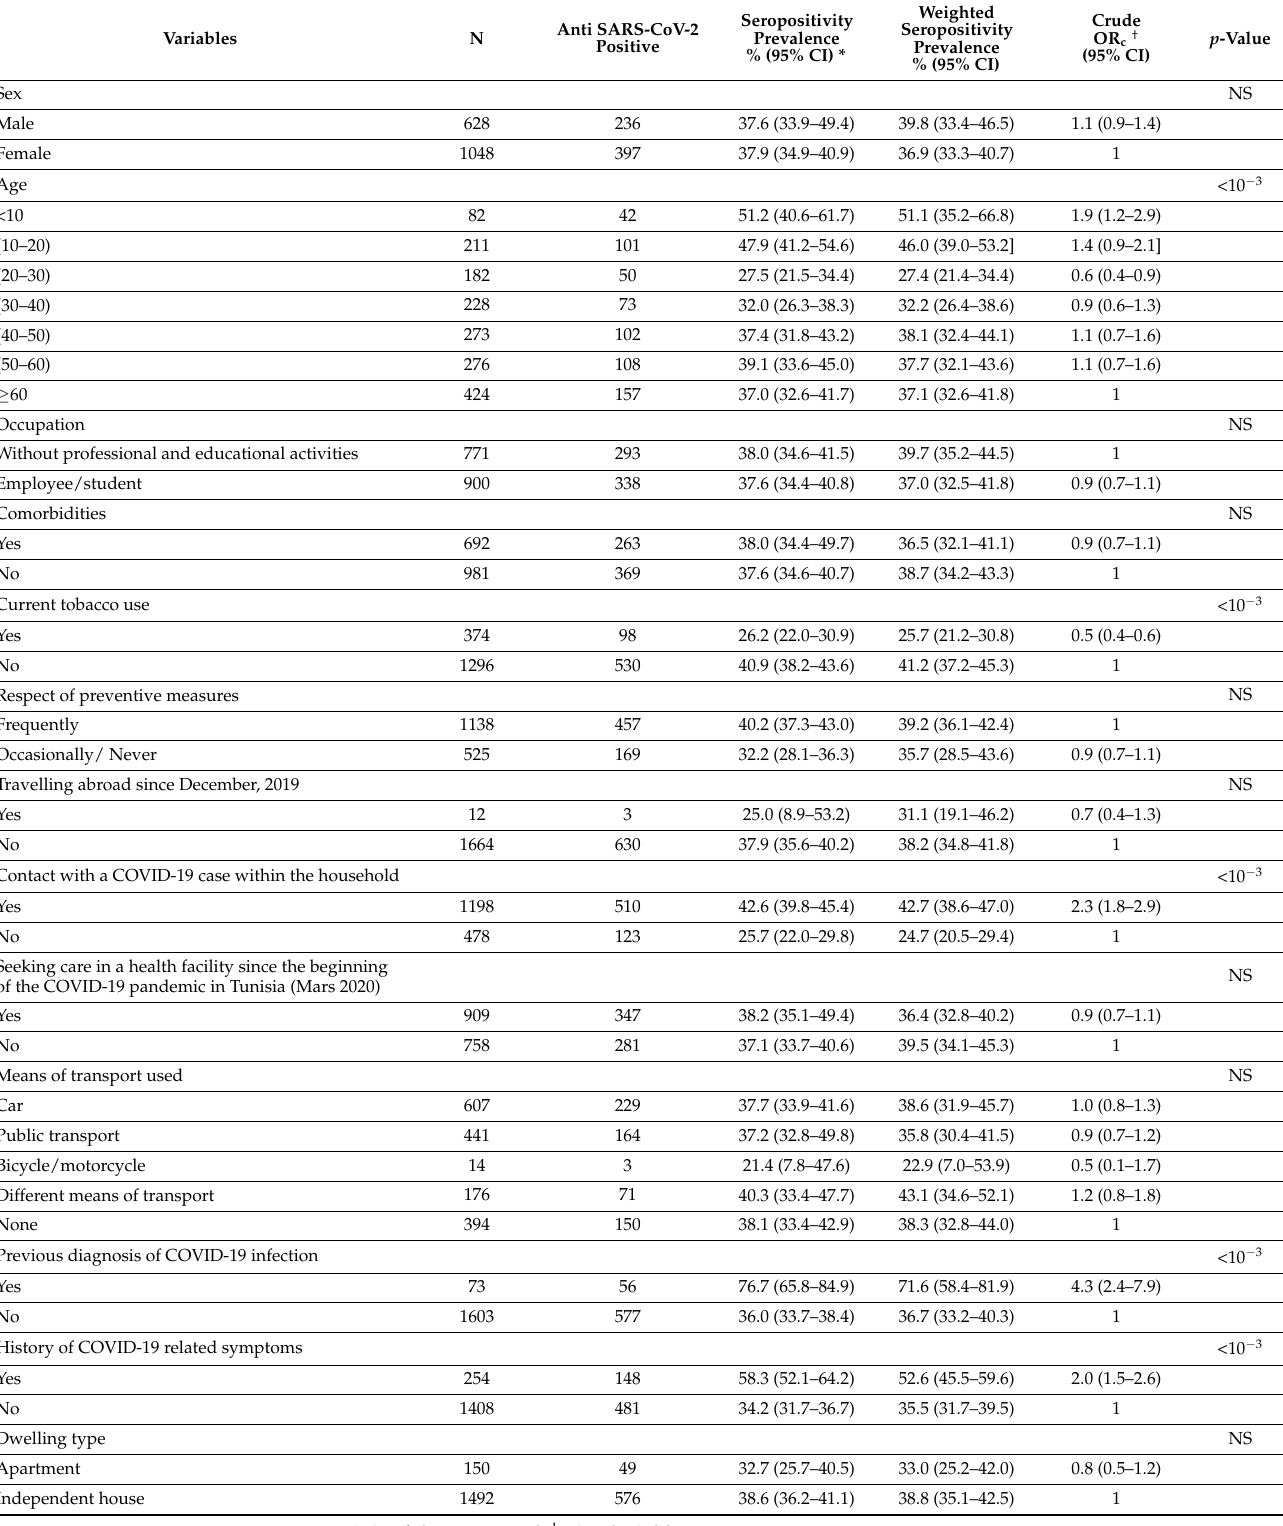
Table 3. Seroprevalence to SARS-CoV-2 according to study variables Tunis,